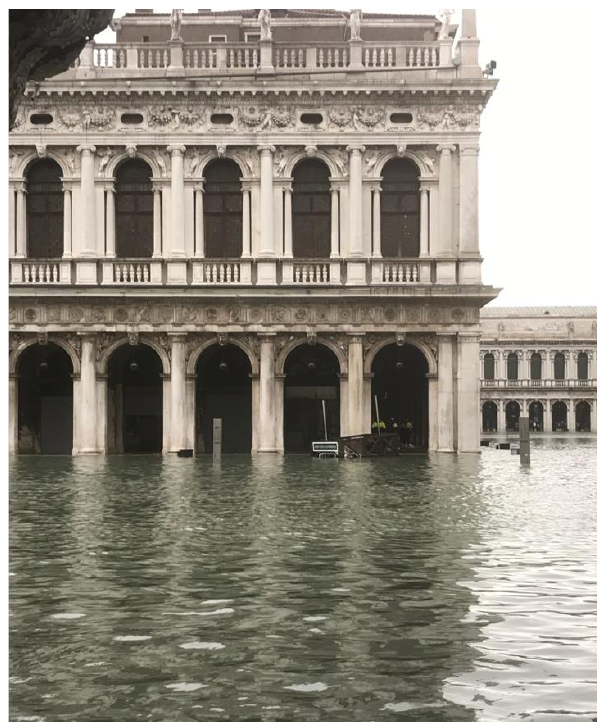
Figure 6. View of the Marciana National Library in St. Mark's Square the morning after the high water peak of November 12,